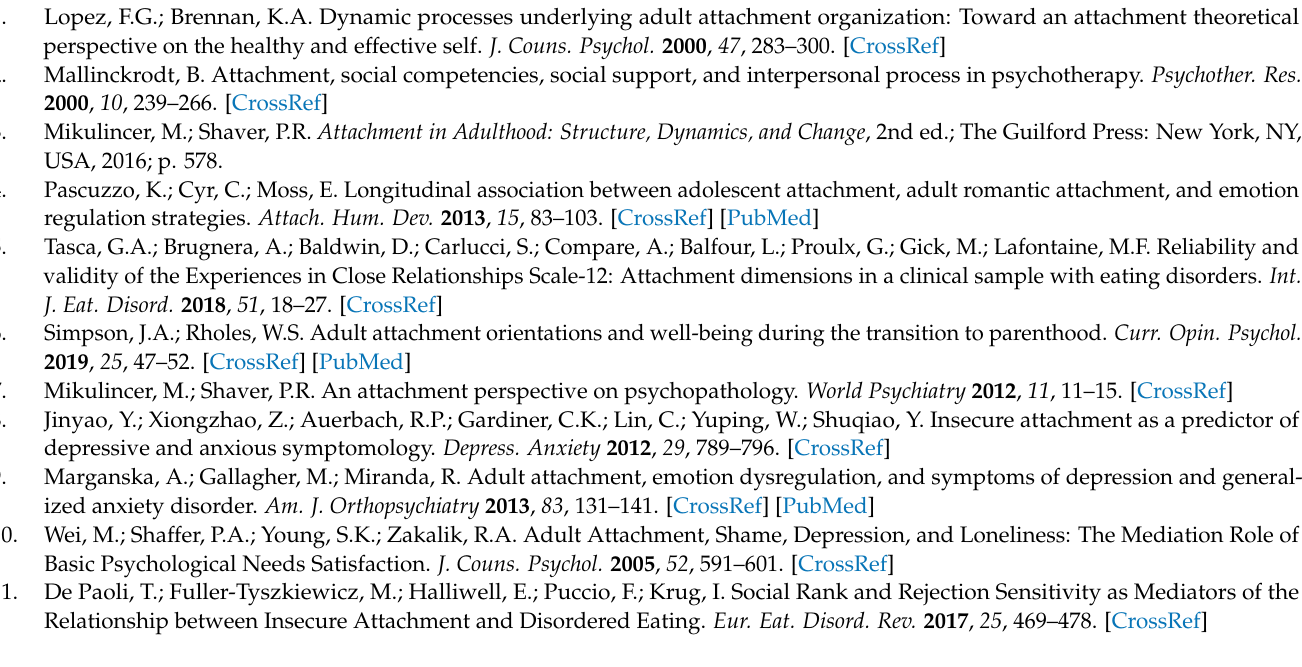
Table S4: Fit Indices for Measurement Invariance Tests of the Hypothesized Model Among Men and